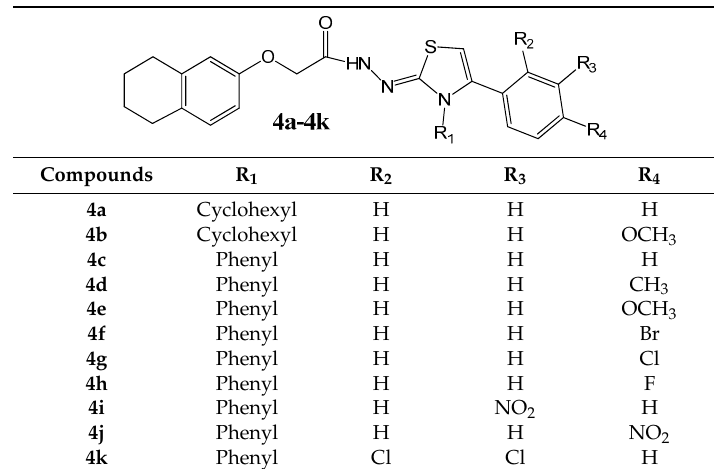
Table 1. The structures of the compounds ( 4a – 4k ).